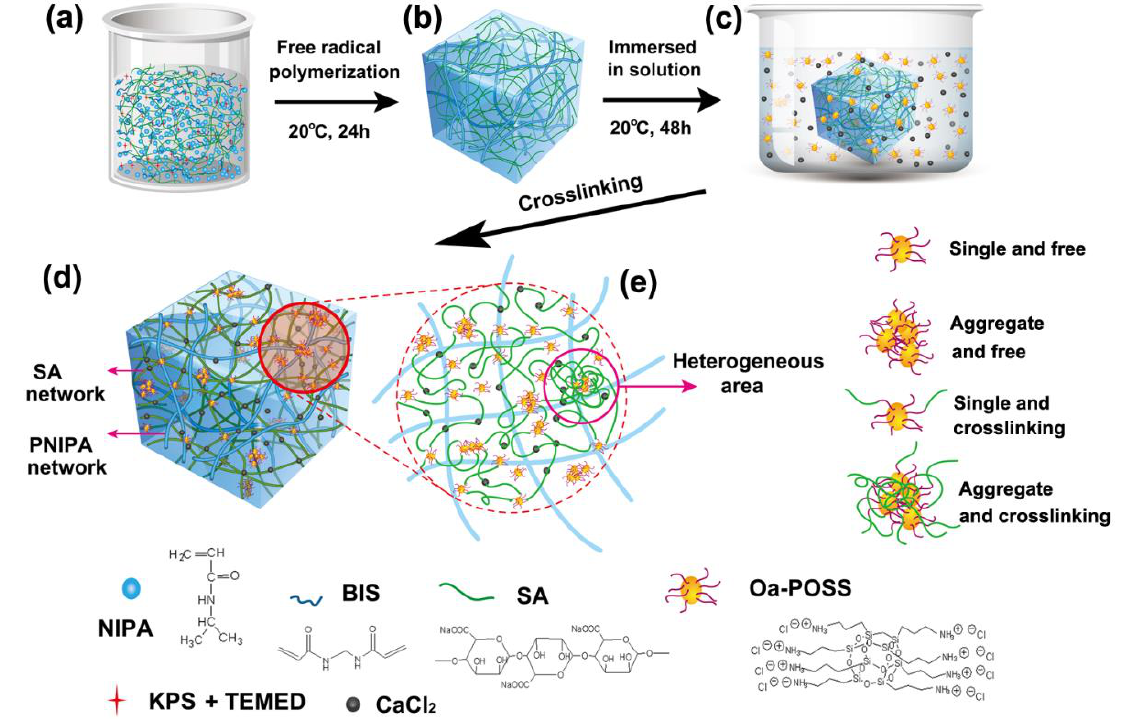
Figure 8. Schematic representation of synthesis process and structure model of OPn-PNm gels: ( a–d ) synthesis process of gels; ( e ) speculated microstructure of network, in which Oa-POSS particles have four states of existence: single and free (existing as single particle without cross-linking), aggregate and free (aggregate without cross-linking), single with cross-linking (single particle with cross-linking point, n = 1–4), aggregate and cross-linking (aggregate with cross-linking). The aggregate and free, and aggregate and cross-linking states cause heterogeneous areas inside the gels.